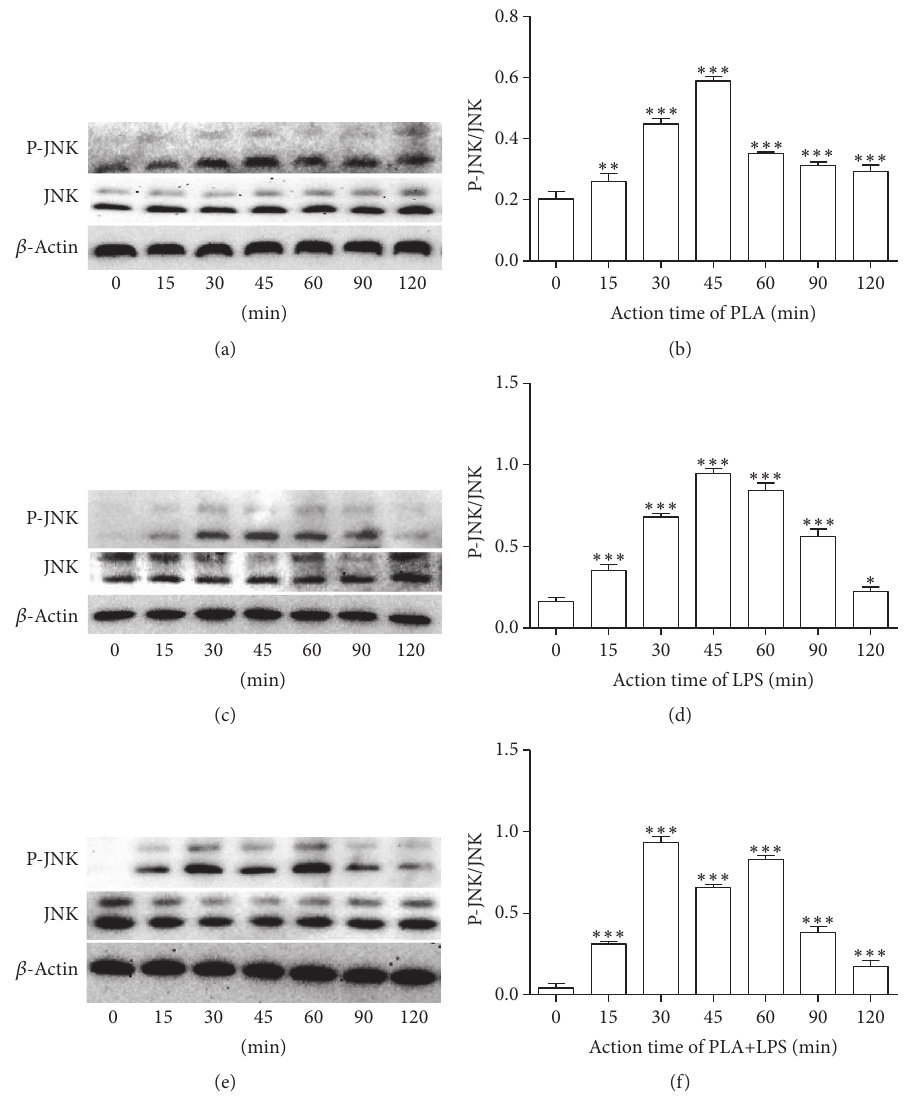
Figure 1: Activation of the JNK signaling pathway by PLA or LPS in NCI-H292 cells. The JNK signaling pathway is activated by 5 𝜇 g/mL PLA, 5 𝜇 g/mL LPS, or 5 𝜇 g/mL PLA + 5 𝜇 g/mL LPS in NCI-H292 cells. Western blot analysis showed expression of JNK and the phosphorylated form of JNK (p-JNK) at various time points (0, 15, 30, 45, 60, 90, and 120 min). 𝛽 -actin was used as an internal protein loading control. ((a) and (b)) The expression level of phosphorylated JNK in NCI-H292 exposed to PLA was increased. ((c) and (d)) The expression level of phosphorylated JNK in NCI-H292 exposed to LPS was increased. ((e) and (f)) The expression level of phosphorylated JNK in NCI-H292 exposed to PLA+LPS was increased prominently. Statistical analyses were compared with the beginning time point: ∗ 𝑃 < 0.05 , ∗∗ 𝑃 < 0.01 , and ∗∗∗ 𝑃 < 0.001